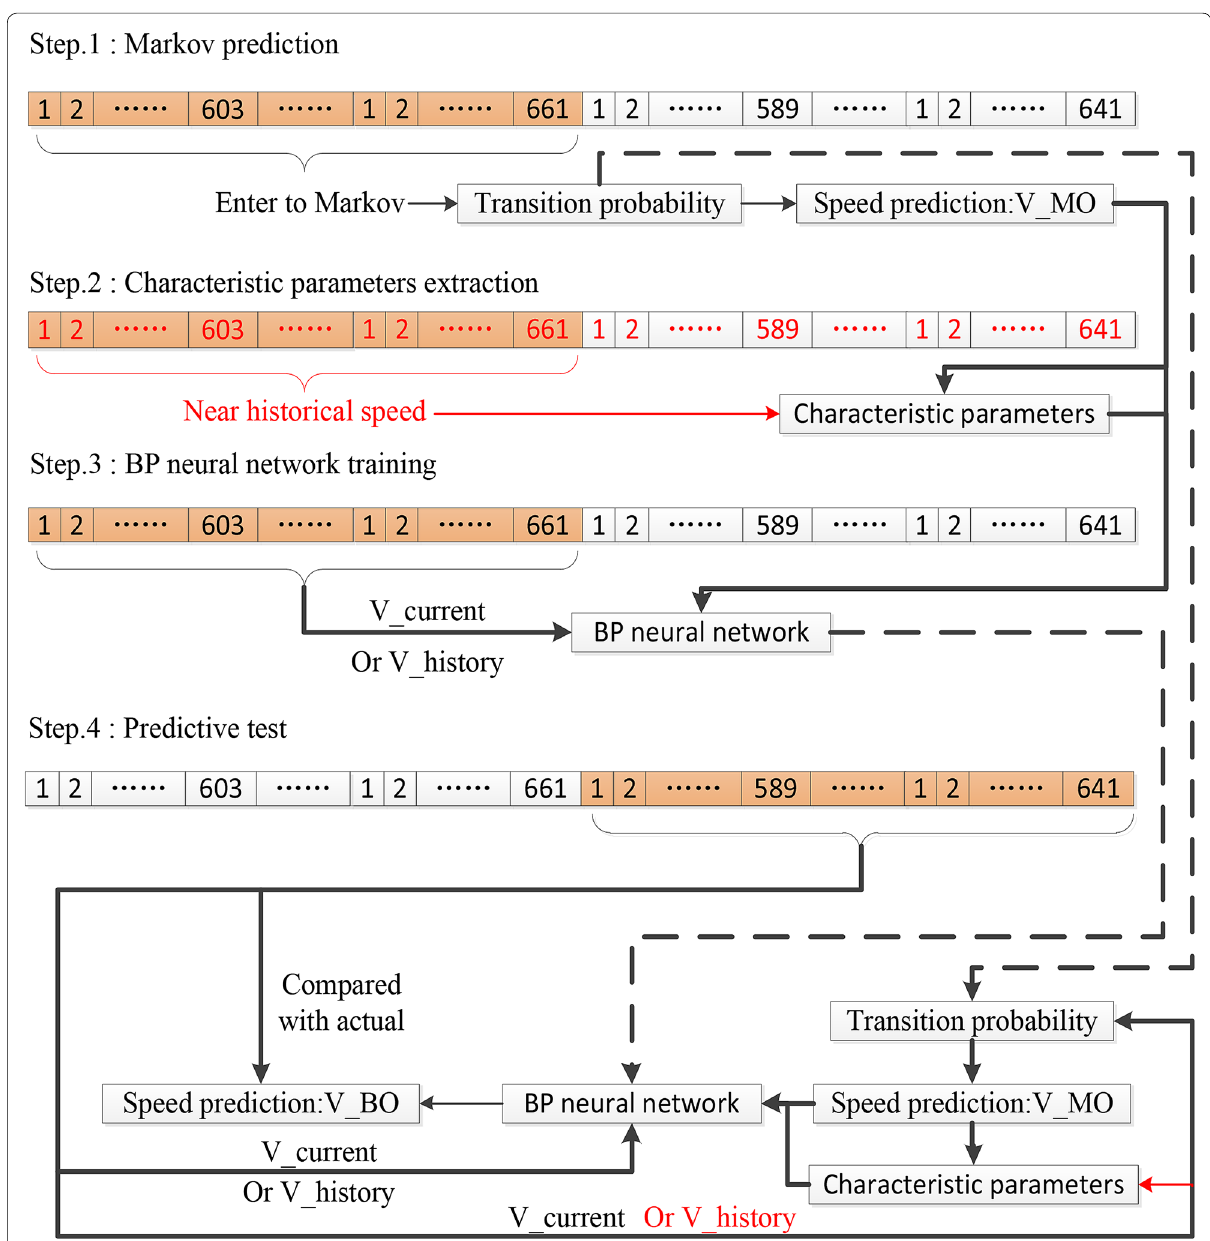
In order to see the above predicted performance more clearly, these images are partially enlarged, as shown in Figure 17. The results are consistent with the charac- teristics of the single prediction model analyzed above. The results of the neural network perform well linearly, while Markov fluctuates greatly. The use of the combi- nation method balances the predicted performance of the two models and the predicted performance is